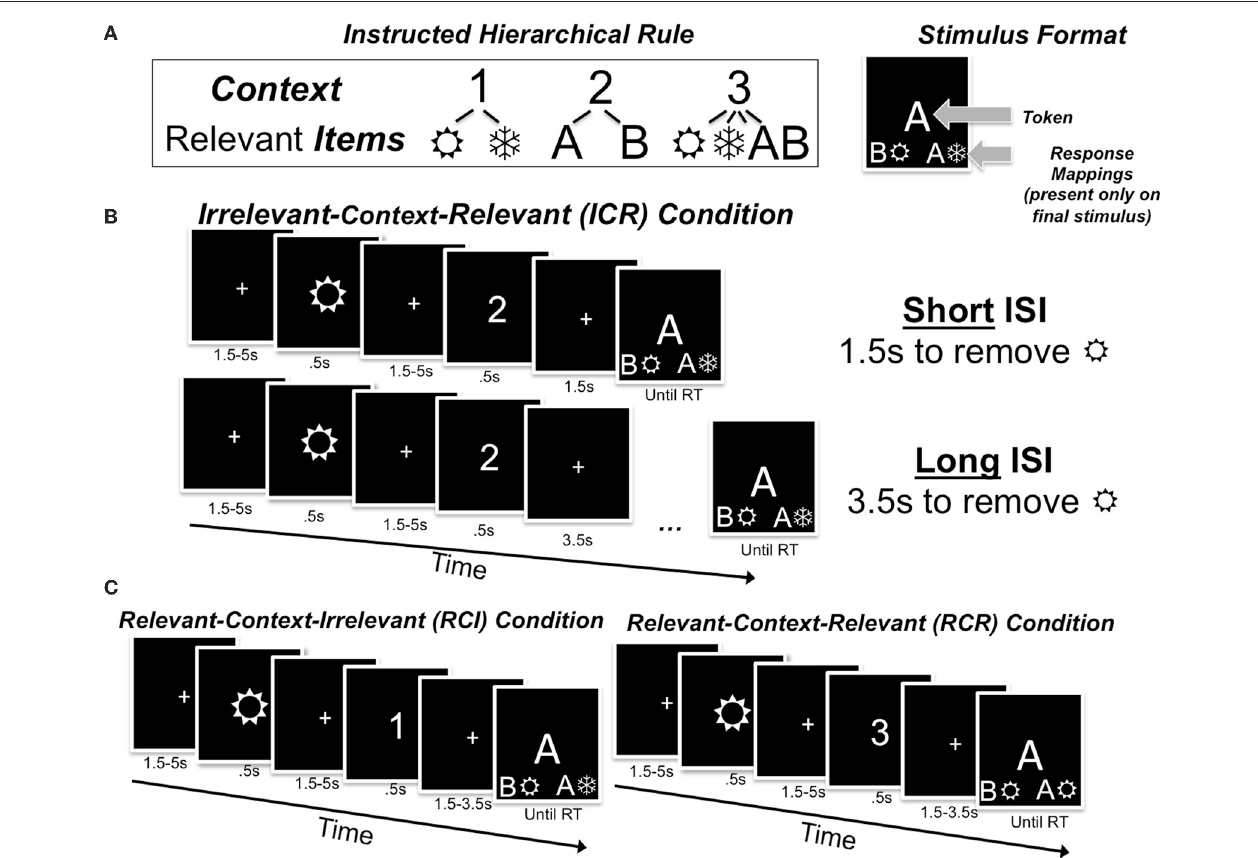
FIGURE 1 | Task rules (A), theinterstimulus interval manipulation (B), and control conditions (C). (A) In this sequential WM task, participants are instructed that digits serve as context in determining which class of lower-level items will be relevant for selecting a response. For example, if the digit “1”/“2” appears, wingdings/letters are relevant for responses (respectively), whereas if the digit “3” appears both of the lower-level items will be relevant. Participants are to identify the relevant centrally-presented item(s) from each trial at the bottom of the final stimulus display, and press a